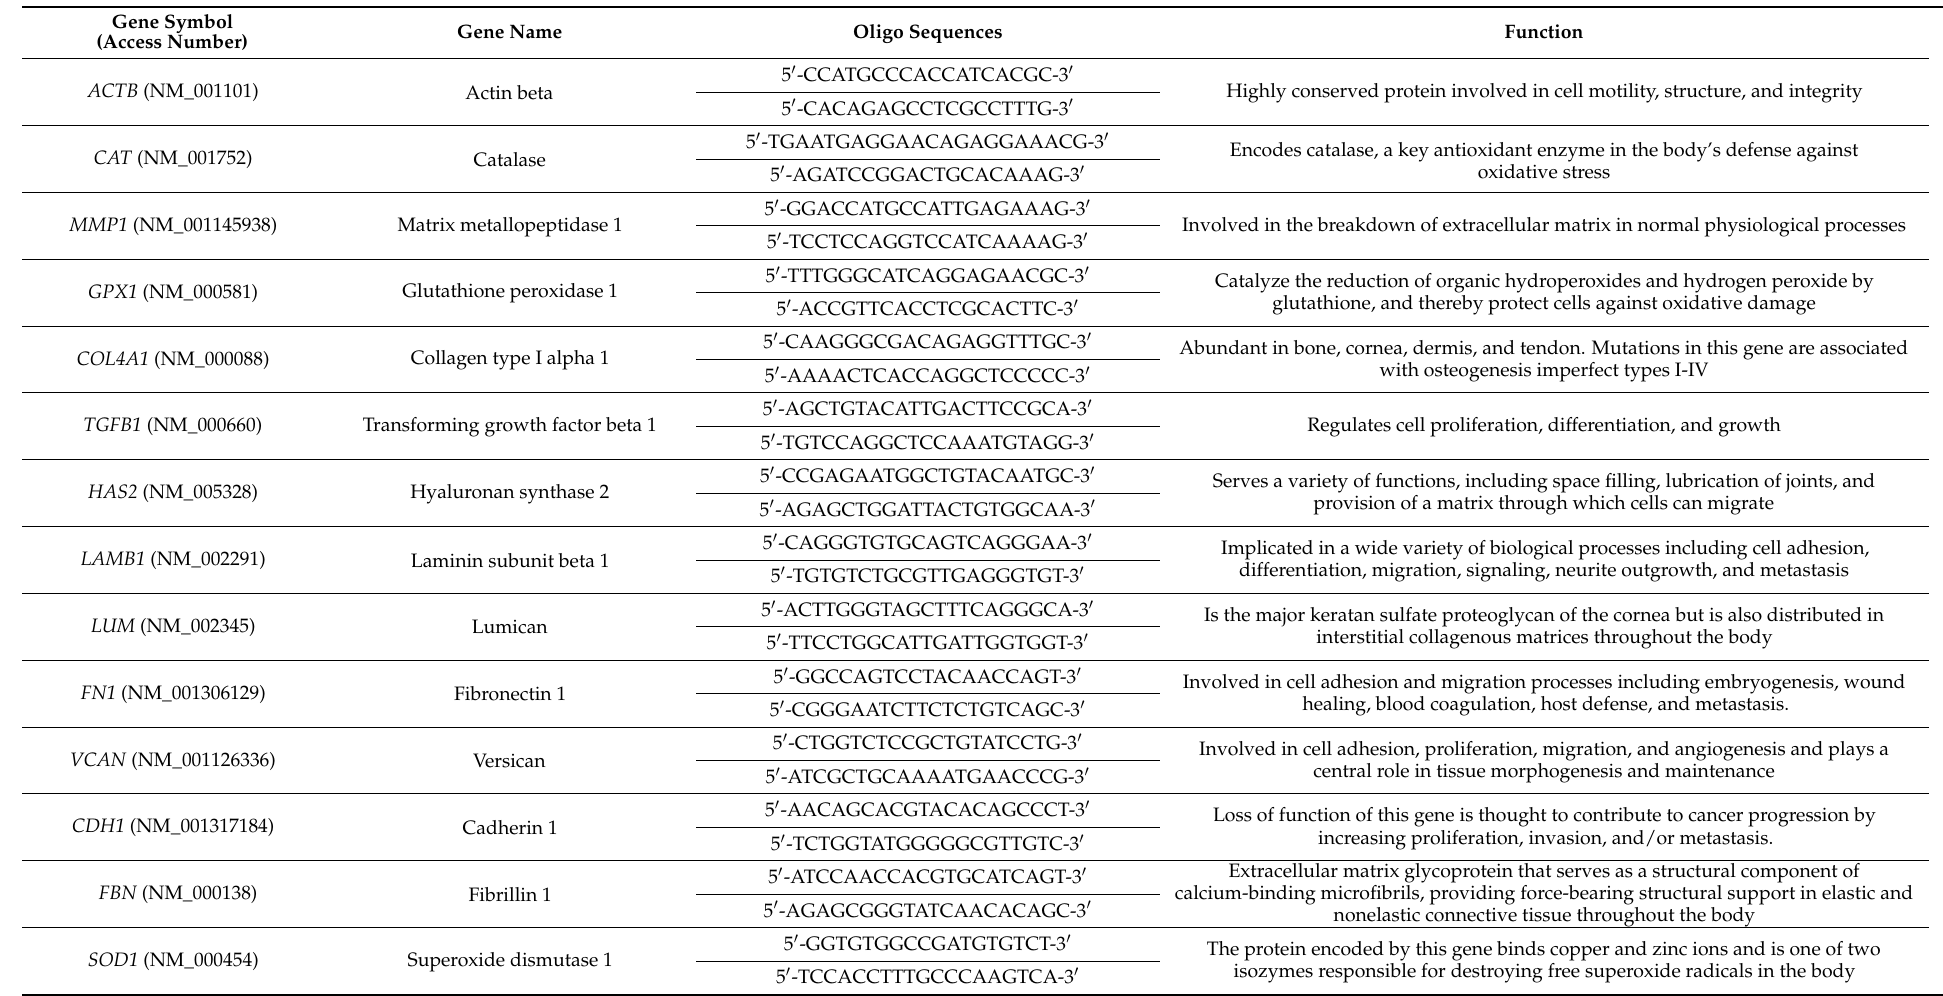
Table A1. Gene symbol, gene name, oligo sequences, and function of specific genes used in RT-qPCR